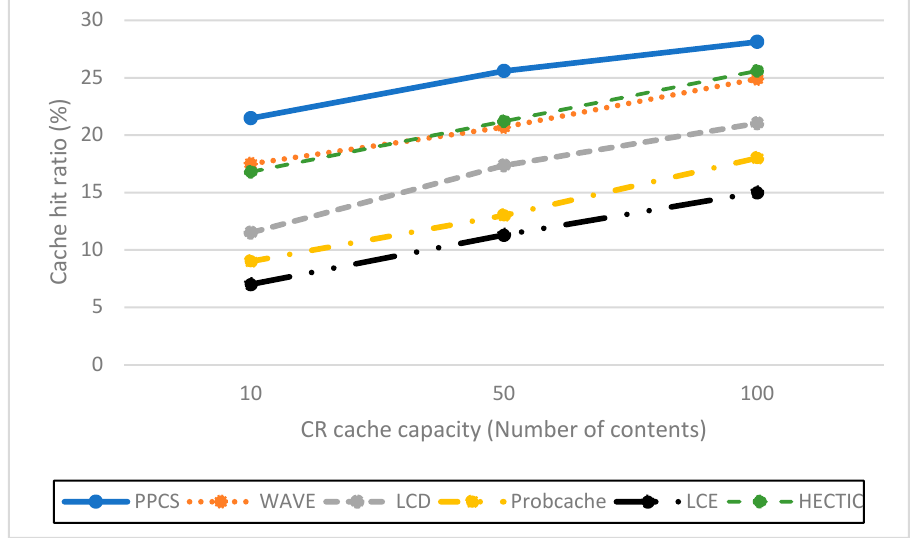
Figure 4. Cache hit rate corresponding to different CS sizes. Figure 6. Cache hit rate corresponding to different CS